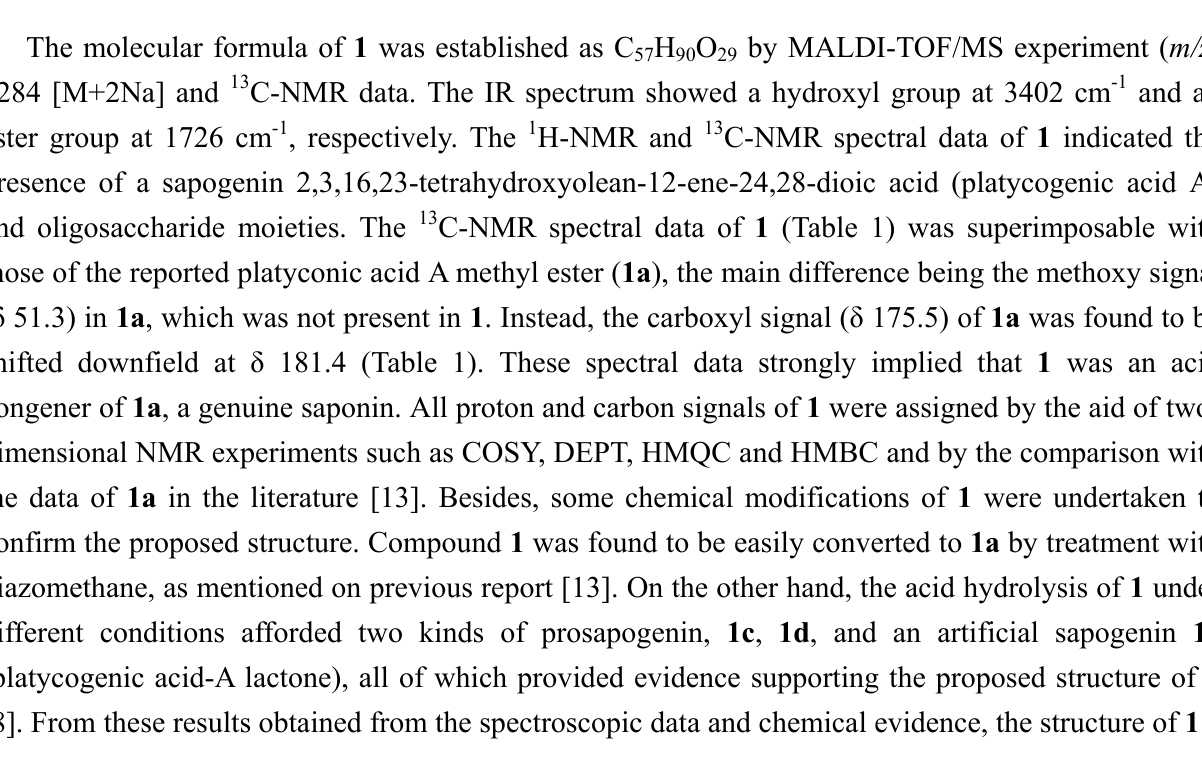
Table 1 . 13 C-NMR spectroscopic data ( δ ) of 1 - 1e